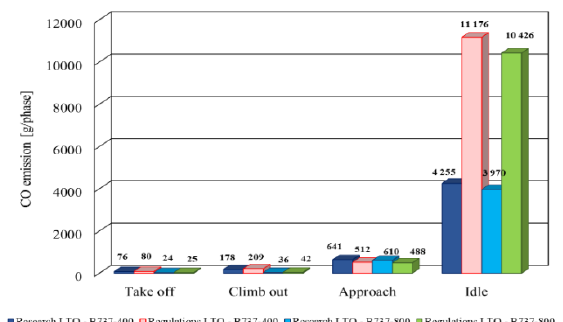
Fig. 9. CO emission for B737-400 and B737-800 in regulations and adopt- ed LTO cycle in each phase